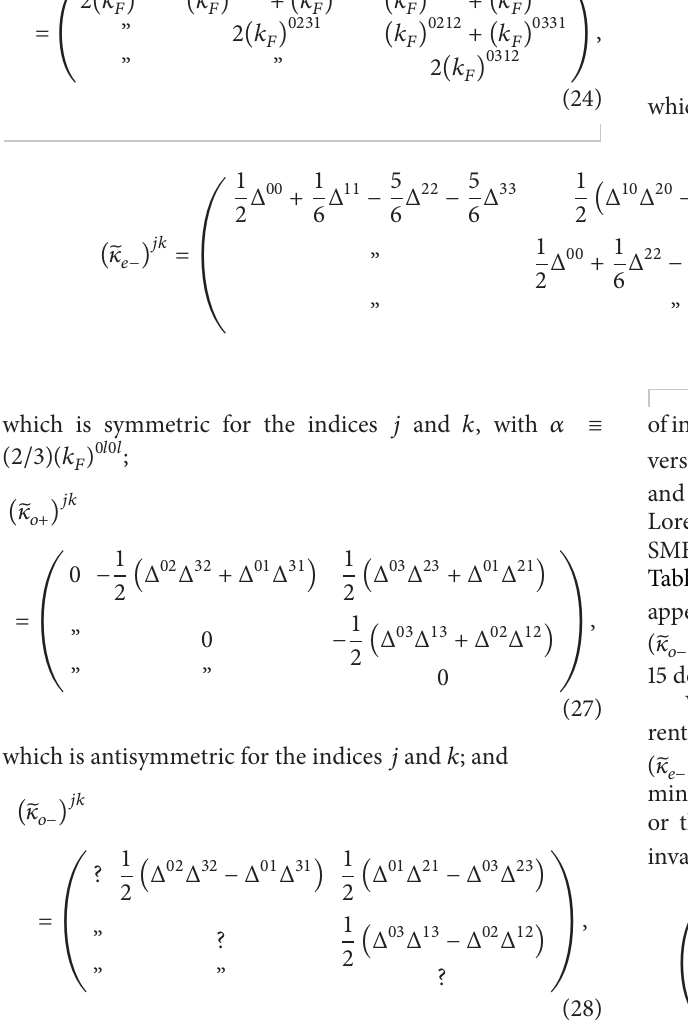
Table 2. The 15 independent degrees of freedom of Δ 𝛼𝛽 are determined, and there is still one freedom Δ 33 remaining unclear. The maximal sensitivity for the elements of Δ 𝛼𝛽 is listed in Table